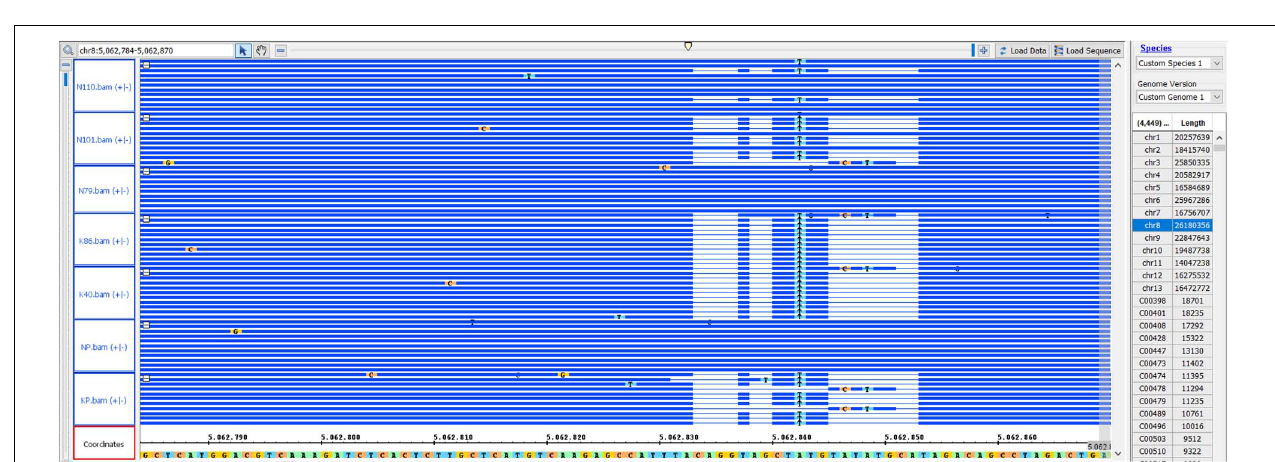
FIGURE 4 | IGB shows the marker position of S8_5062843 for the selected genotypes. NP, shattered capsule parent; KP, non-shattering capsule parent. N110, N101, and N79 are F 2 lines that had the shattered capsule trait. K40 and K86, non-shattering lines in F 2 . The coordinates show the reference genome